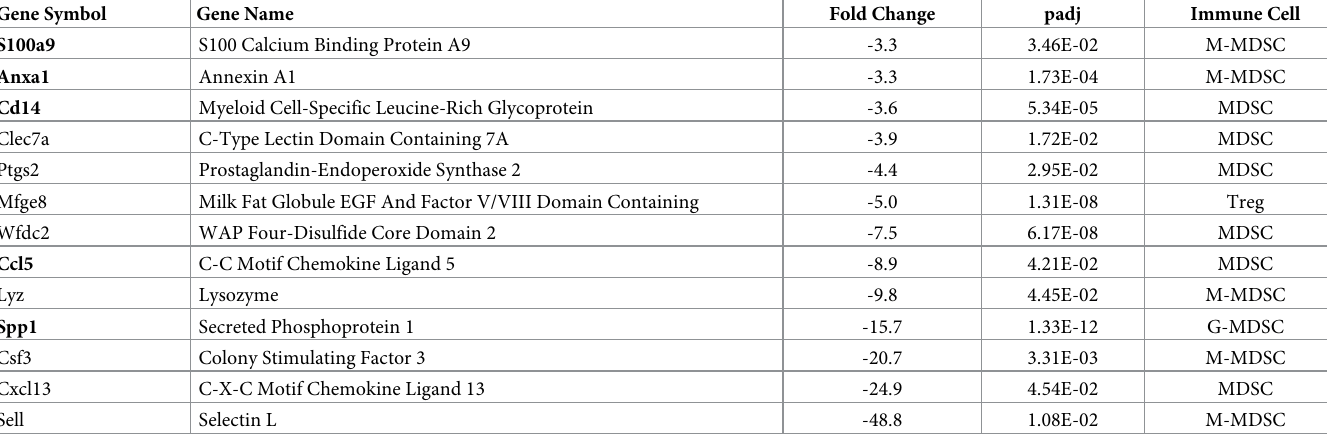
The immune suppressive cell type is based on the Human Protein Atlas (https://www.proteinatlas.org) and UniProt (https://www.uniprot.org/uniprot) databases. Genes with a padj < 0.05 are listed and those containing an LXRE are in bold . Data are taken from S3 Table in S1 File.